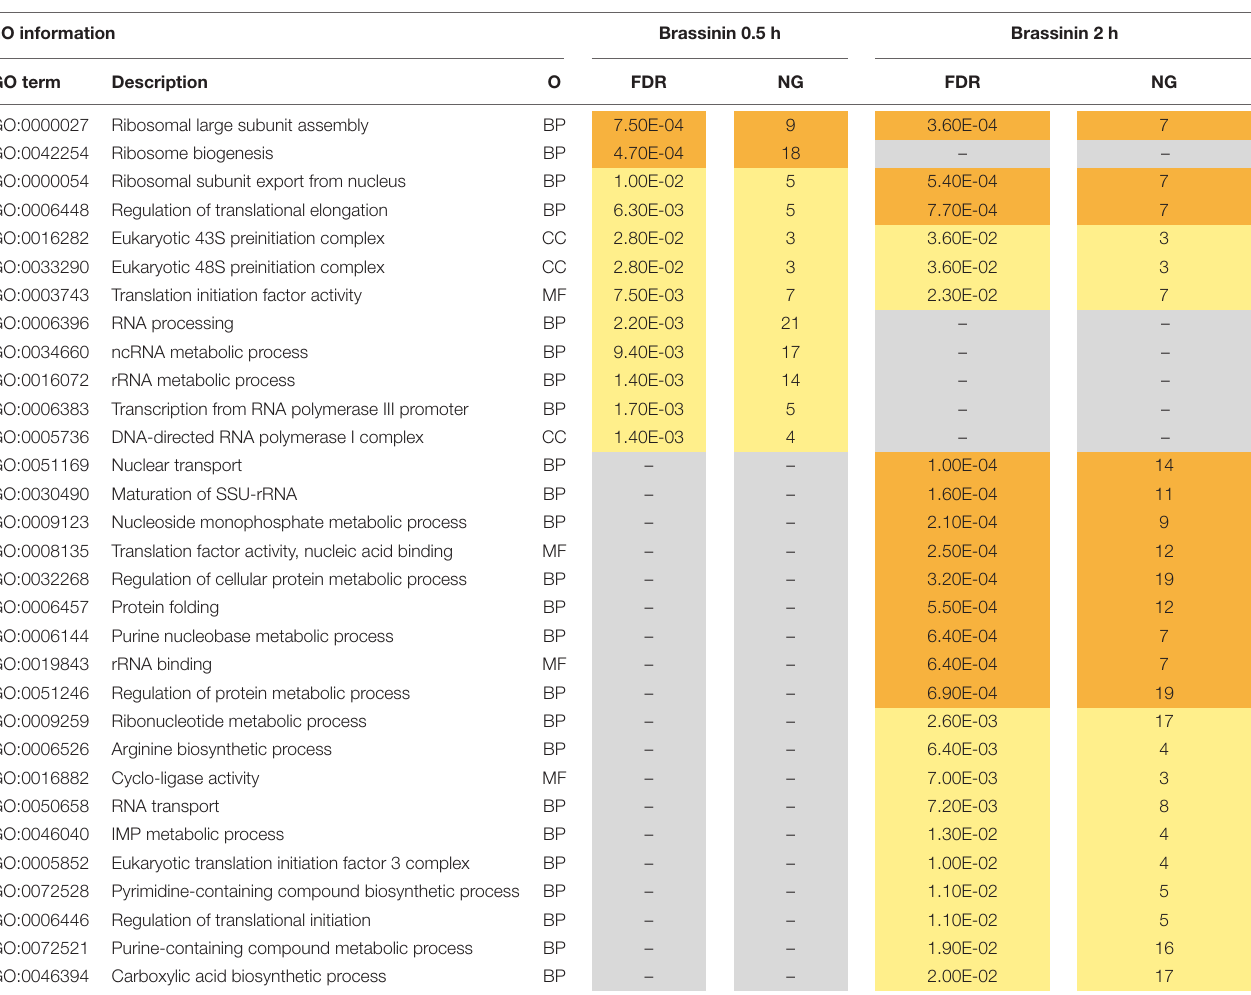
TABLE 1 | Gene ontology (GO) enrichment analysis on down-regulated genes related to brassinin exposure. GO information Brassinin 0.5